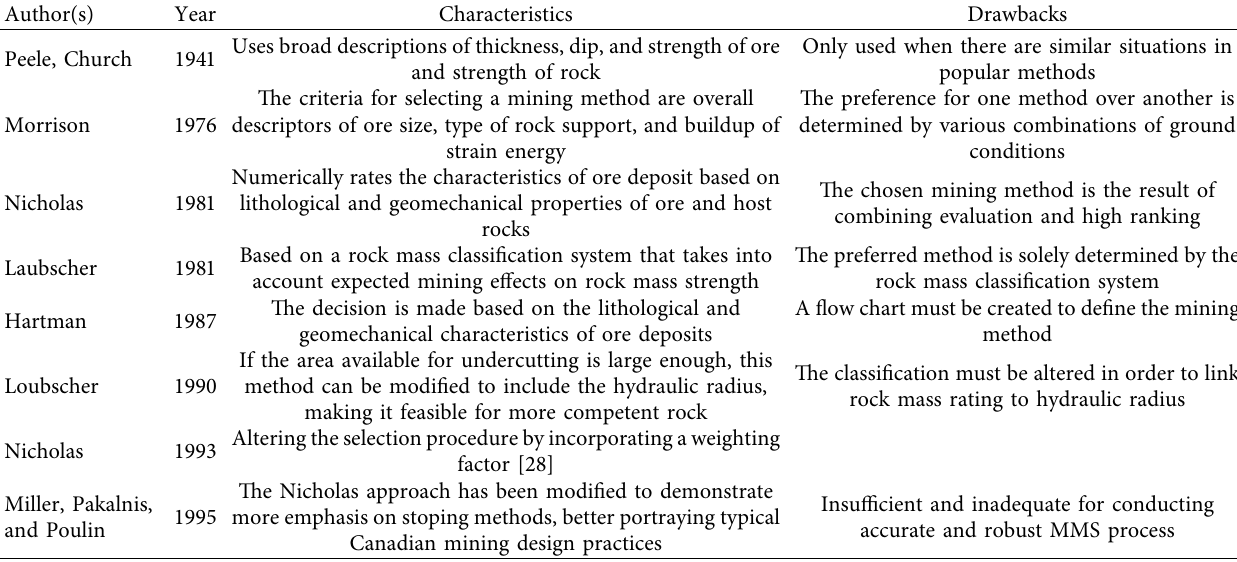
Table 1: Summary of the existing mining method selection (MMS) techniques and main issues associated with